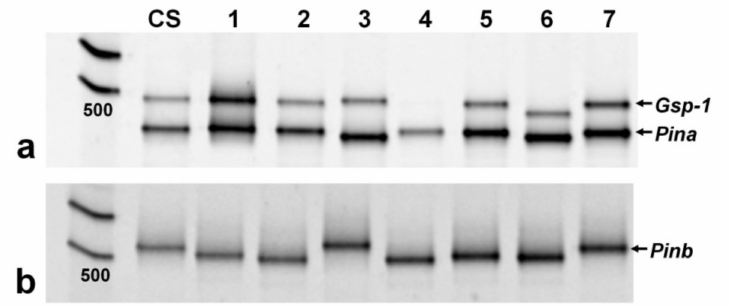
are as follows: CS , common wheat cv. Chinese Spring; 1 , PI 554559; 2 , PI 427622; 3 , PI 554504; 4 , PI 554548; 5 , PI 427453; 6 , PI 470720; and 7 , PI